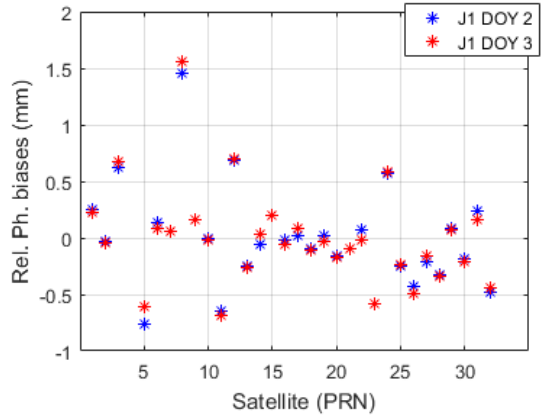
Figure 11: Sigma phase biases between signals L2C and L2W on DOY 2 and 3 in